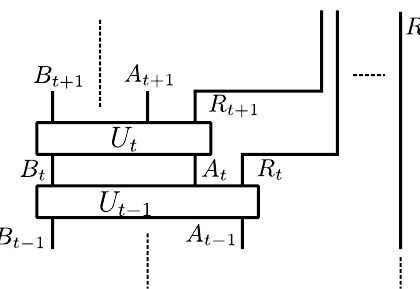
Figure 9 . The dynamics of an evaporating black hole. R join R while A t are the con(cid:12)ned